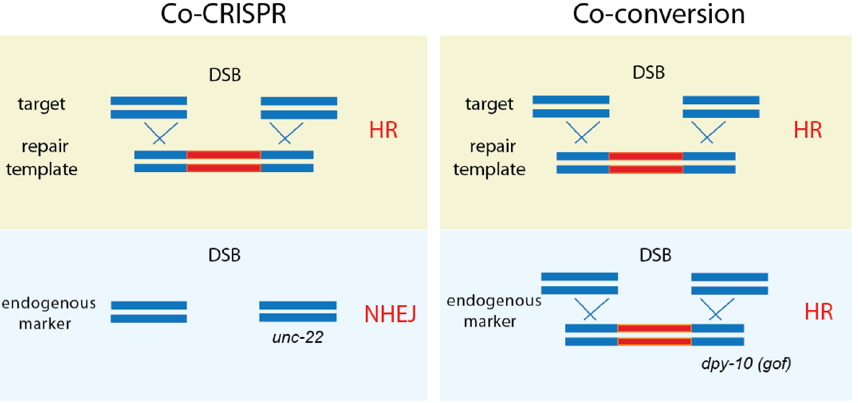
Figure 3. Co-CRISPR and co-conversion. Both methods employ an endogenous marker gene that exhibits phenotypic changes, thus ensuring that proper genome editing is processed. While Co- CRISPR uses NHEJ for targeting marker genes, co-conversion relies on homologous recombination (HR) via a repair template.